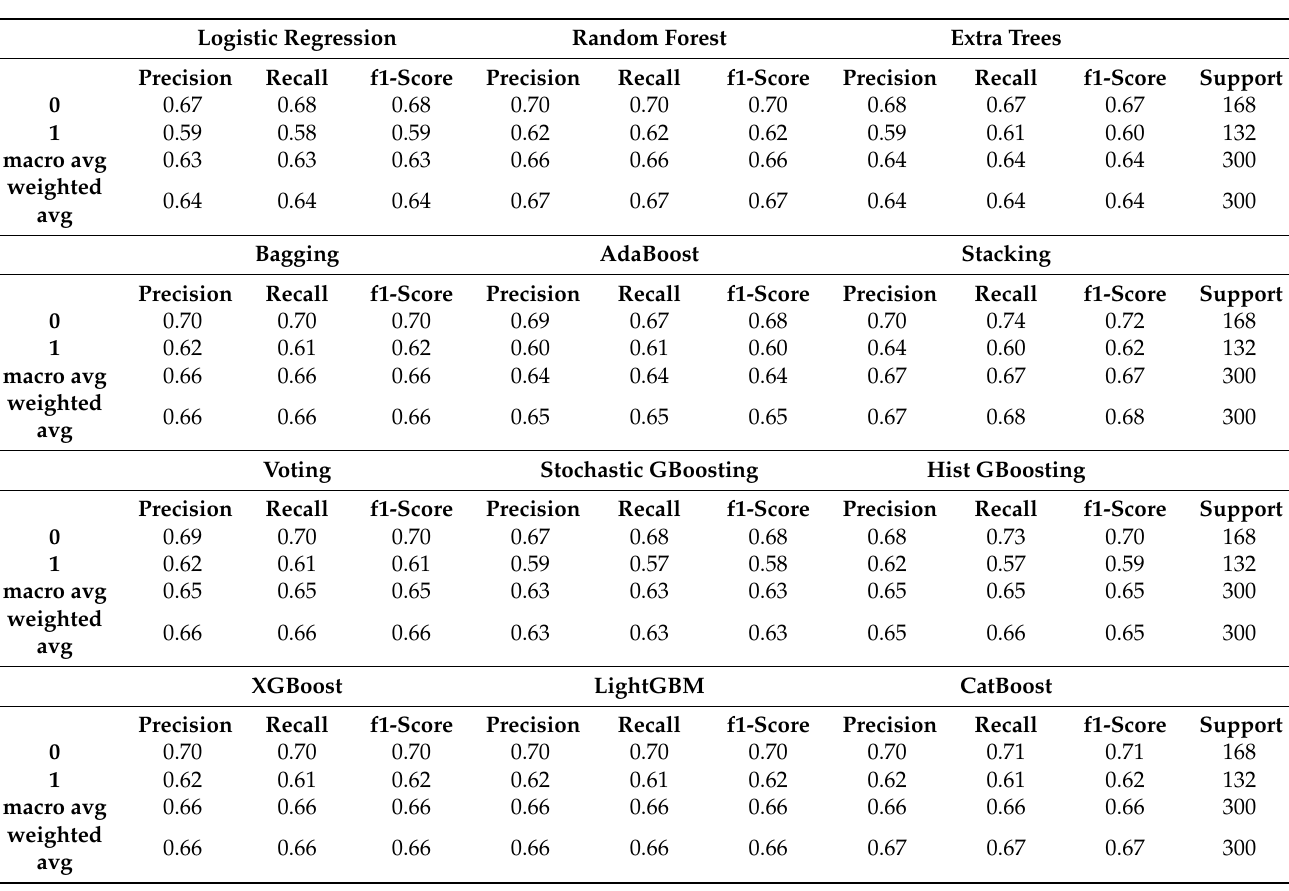
Table A2. Classification